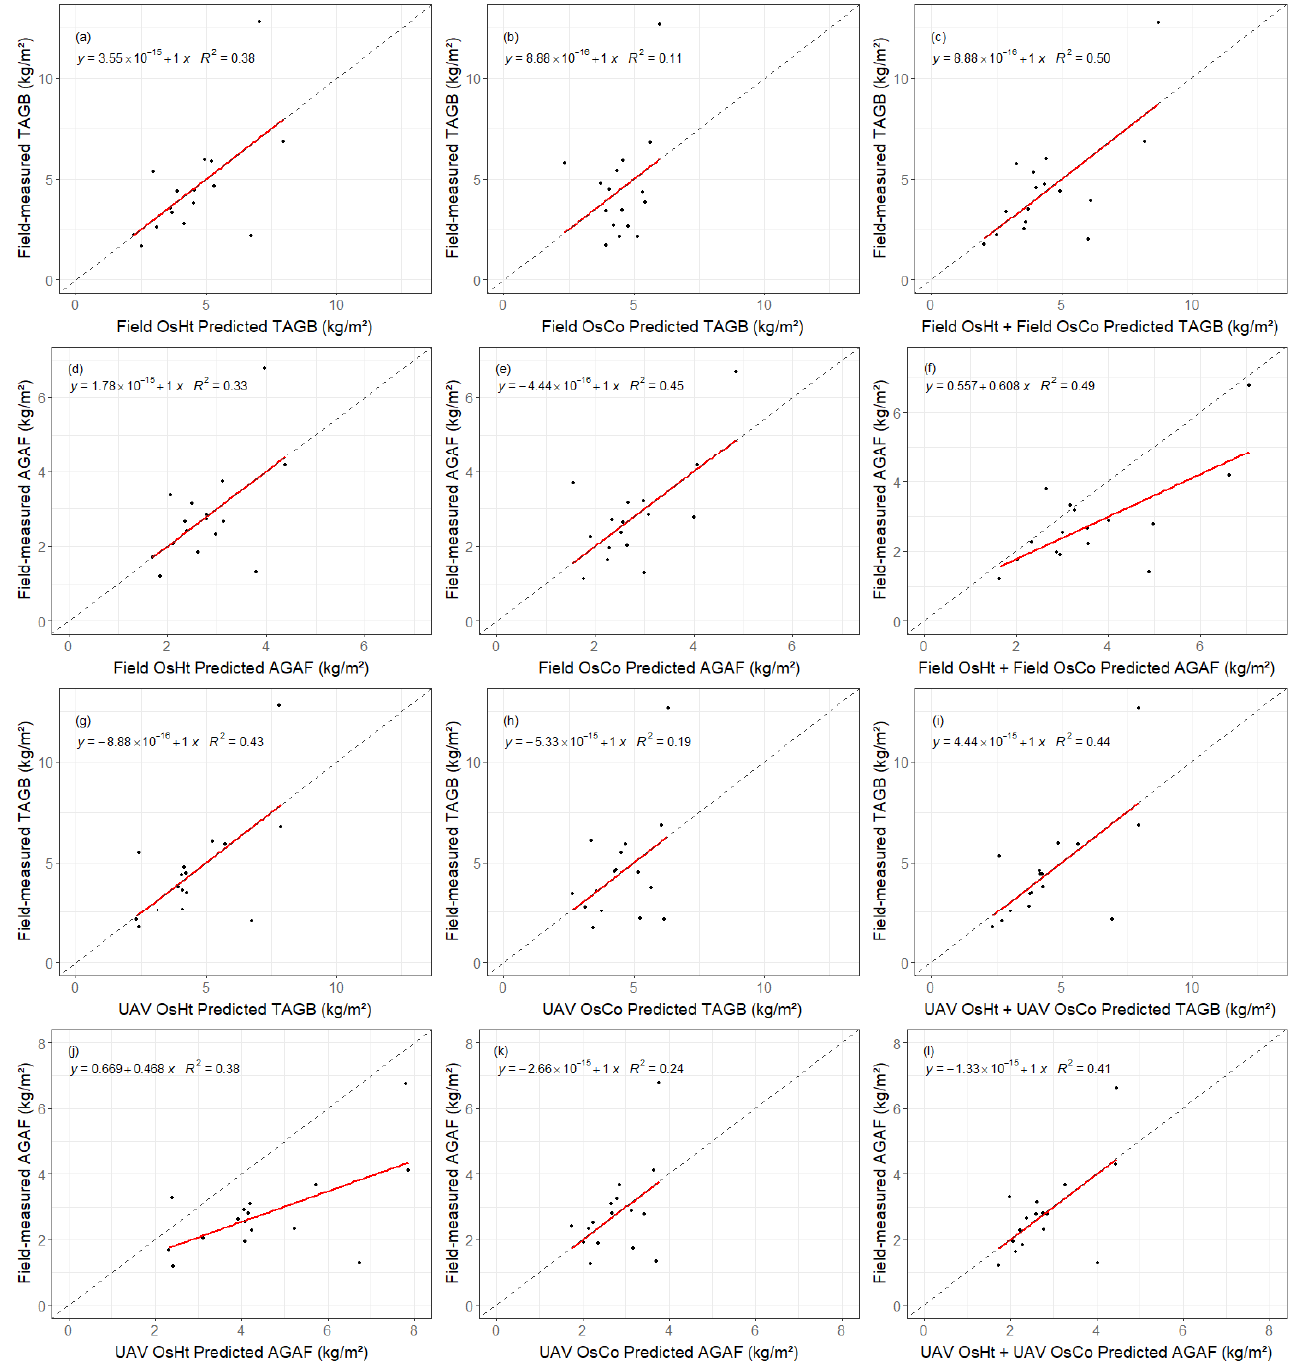
Figure 9. Plots showing correlation between ( a ) destructively sampled TAGB and field-measured ( a ) OsHt, ( b ) OsHt, ( c ) OsHt + OsCo, ( g ) UAV-sampled OsHt, ( h ) UAV-measured OsCo and ( i ) UAV-sampled OsHt + OsCo; destructively sampled AGAF and field-measured ( d ) OsHt, ( e ) OsHt, ( f ) OsHt + OsCo, ( j ) UAV-sampled OsHt, ( k ) UAV-measured OsCo and ( l ) UAV-sampled OsHt + OsCo. The dashed black line represents the 1:1 line, and the solid red line and equation represents the line of best fit.